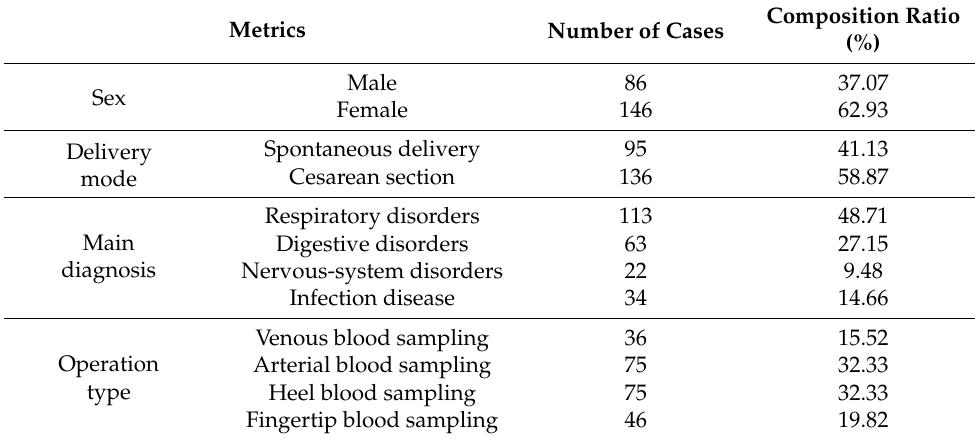
Table 1. Demographic characteristics of newborns in this